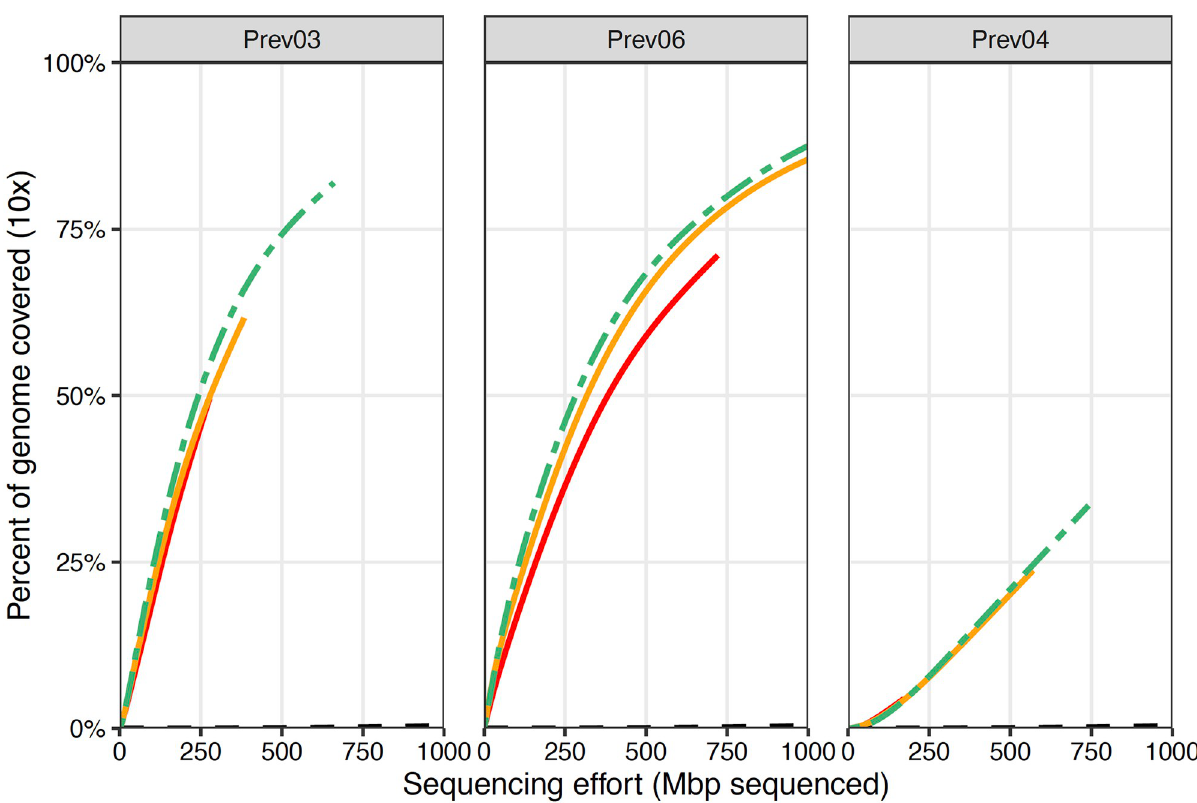
Fig 6. Deeper sequencing of the three successful primer sets—Prev03, Prev06, and Prev04—confirms the efficient and even selective amplification of P. melaninogenica . The solid colored lines indicate individual replicates and the green dashed line represents the pooled total. Each of the three primer sets yield dramatic increases in sequencing depth compared to the unamplified samples (black dashed line). Each primer set reached 10 × coverage across 23–74% of the target genome, while the unamplified samples reached 10 × coverage at < 1% of the target genome, with 500 Mbp of sequencing